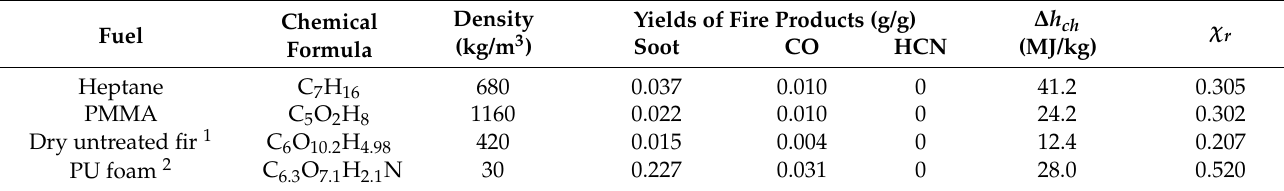
Table 2. Fuel properties